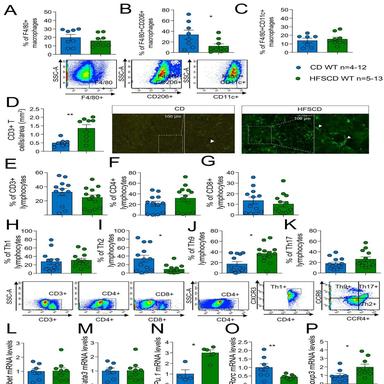
HFSCD-fed WT mice display hepatic inflammatory profile and altered inflammatory transcription factors. Percentage of (A) total F4/80+, (B) anti-inflammatory F4/80+CD206+ and (C) proinflammatory F4/80+CD11c+ macrophages in alive cells from hepatic stromal vascular fractions (SVF) determined by flow cytometry. Representative flow cytometry plots displaying the gating strategy for the different populations are displayed below the quantifications. (D) Content of CD3+T cells, expressed as number of cells per are